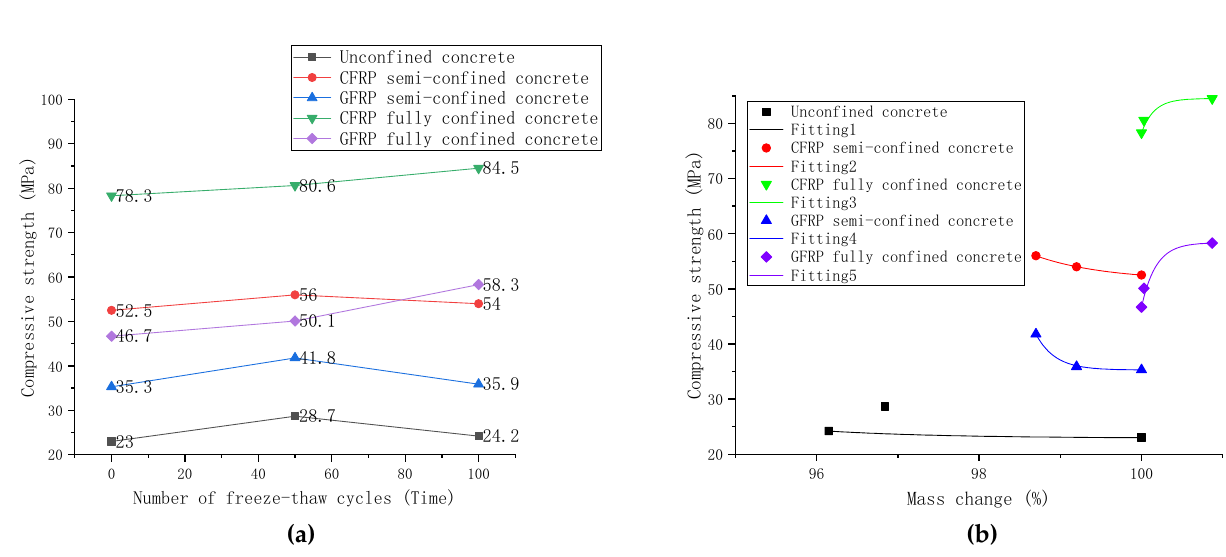
(b)(a) Figure 10. Comparison of different confined technologies and material changes: ( a ) variation of concrete strength with different confinement techniques; ( b ) the relationship between mass change and